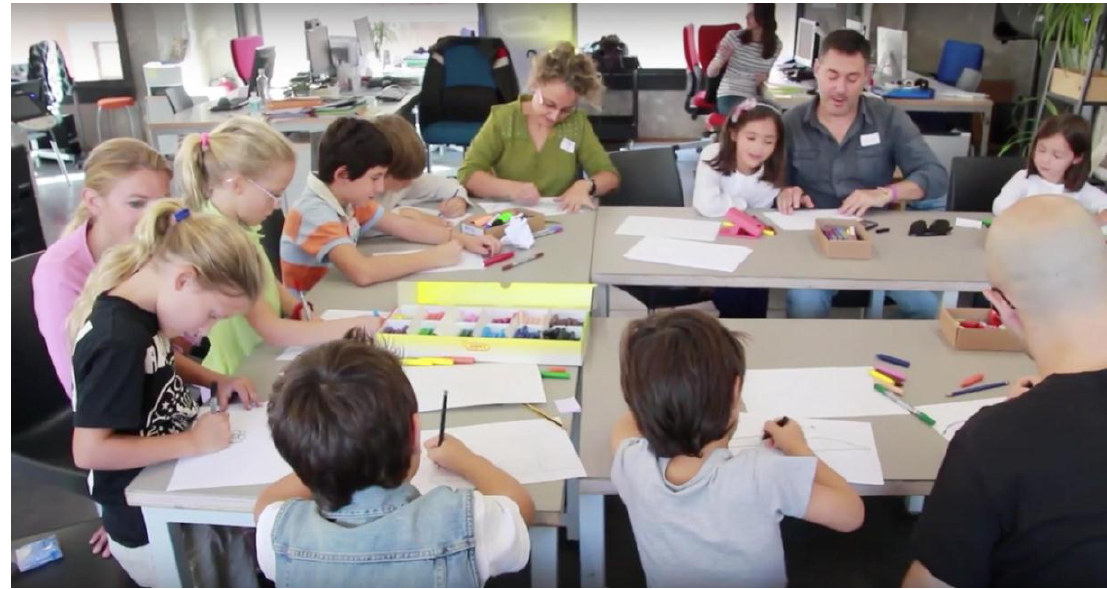
Figure 17. Children and parents designing their own games for HybridPLAY at the Medialab-Prado (Madrid, Spain) workshop.